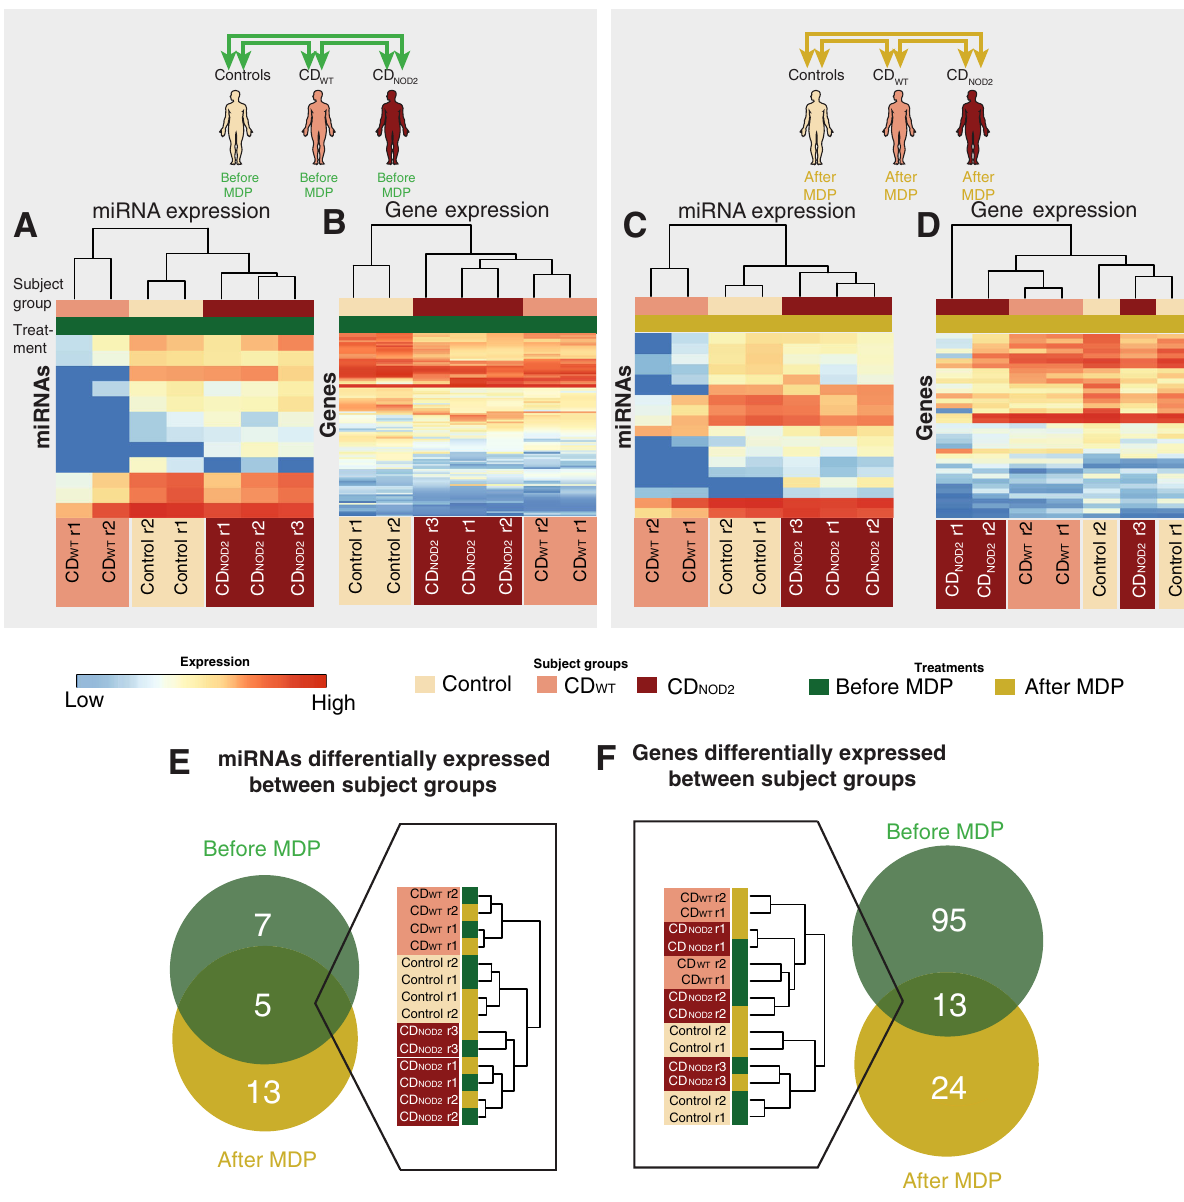
Fig. 2 miRNA and gene expression patterns between subject groups. a Heat map showing the expression pattern of differentially expressed miRNAs between subject groups before MDP stimulation ( green arrows in Fig. 1, also shown as schematics on top ). Expression values are broken into permilles and assigned to a color gradient ranging from red (high expression) to blue (low expression). Rows indicate individual miRNAs, while columns show individual subjects. Rows and columns are ordered by hierarchical clustering using Euclidian distance, where the top dendrogram indicate similarity between subjects. Subject groups and MDP treatment are indicated by color above the heat maps. Note the clear separation between CD WT , CD NOD2 , and controls. b As in a , but showing differentially expressed genes (by RNA-Seq) between subject groups before MDP treatment. c As in a , but showing differentially expressed miRNAs between subject groups after MDP stimulation. Note the clear separation between CD WT , CD NOD2 , and controls. d As in a , but showing differentially expressed genes between subject groups after MDP treatment. e Left : Venn diagram showing the overlap between differentially expressed miRNAs between subject groups before and after MDP treatment. Right : expression-based clustering of the fi ve shared miRNAs as in a , but only showing subjects, treatments, and the resulting dendrogram (color codes as in a – d ). Note that subject groups are clearly separated, while MDP treatment status is not. f As in e , but for differentially expressed genes. Note that the shared gene set is not as ef fi cient at distinguishing subject groups as the miRNA expression